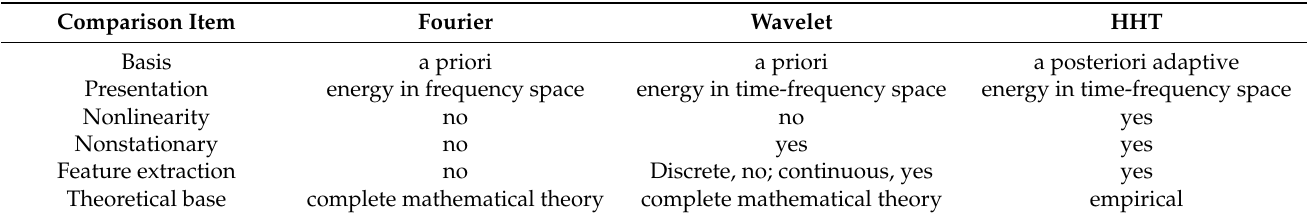
Table 1. Comparison of commonly used signal processing